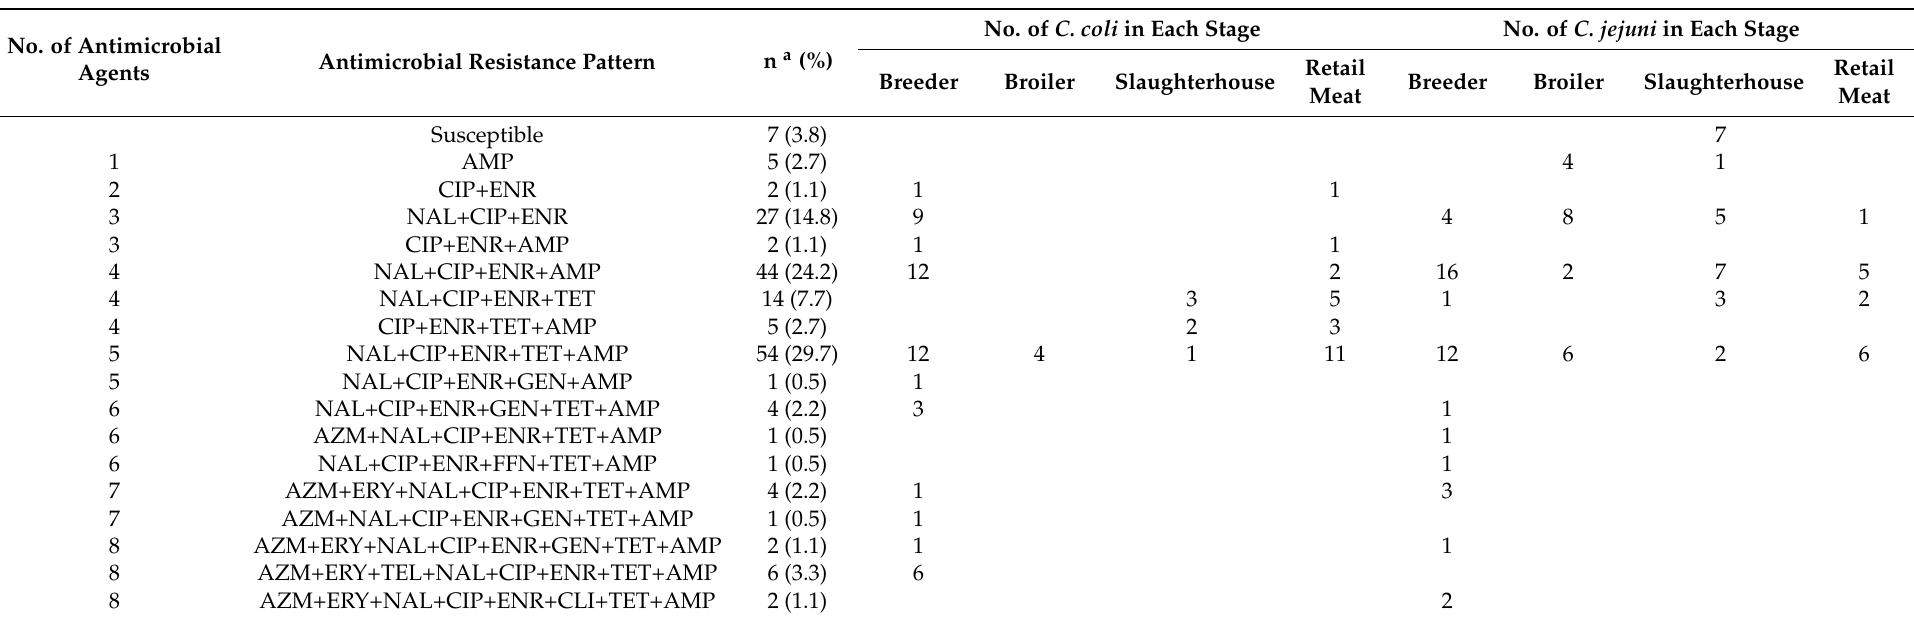
Table 3. Antimicrobial resistance patterns of Campylobacter coli and C. jejuni isolates from the chicken production